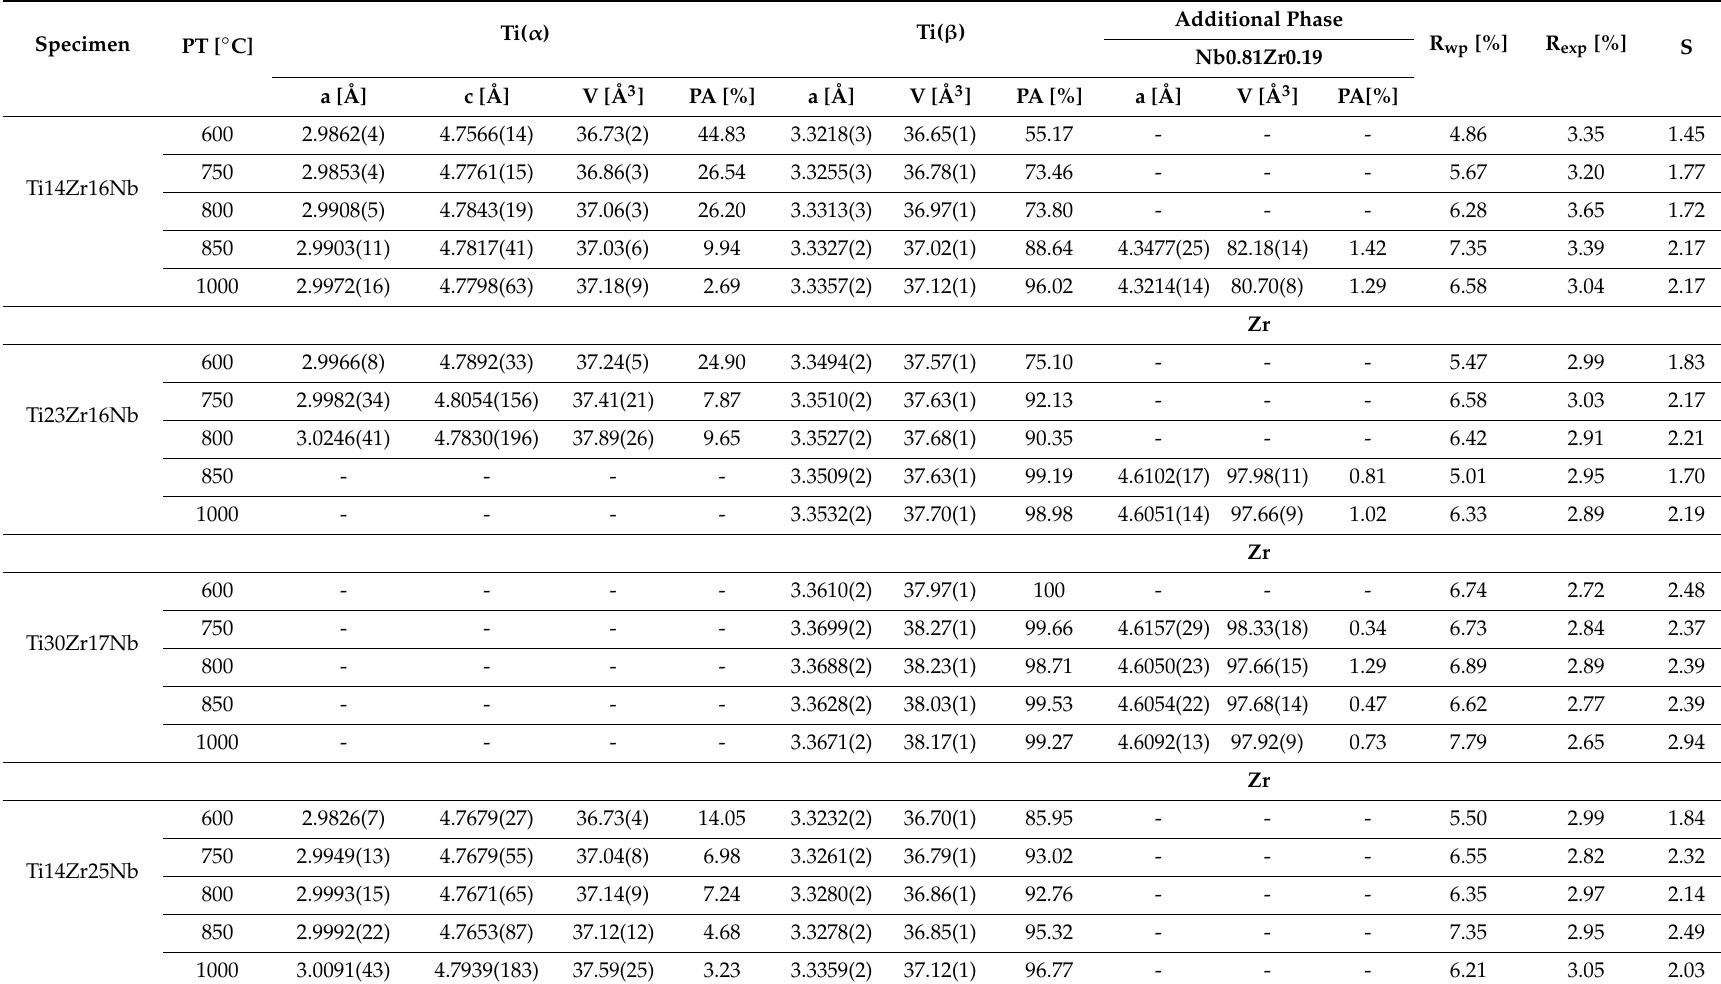
Table 2. Crystallographic data analysis of bulk Ti-Zr-Nb specimens sintered at di ff erent